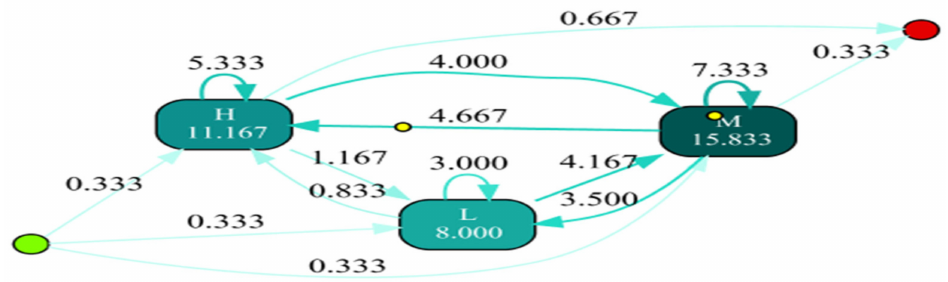
Figure 16. DFvM model showing paths and deviations (no deviations found).